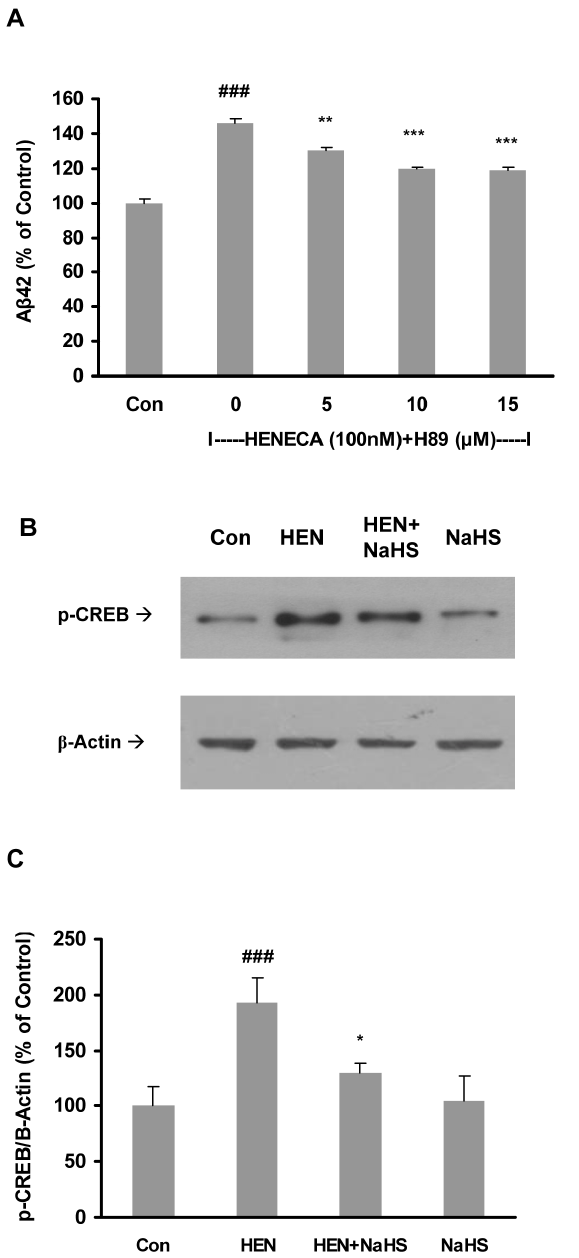
Figure 5. Effect of NaHS on expression of A2A receptors. A–B : Representative gels (A) and histogram (B) demonstrating the effect of pretreatment with NaHS (100 m M, 12 hours) did not attenuate the effects of HENECA (100 nM, 24 hours) on protein expression of A2A receptor. C : Effect of NaHS (100 m M) on production of A b 42 in cells pre- treated with A2A receptor antagonist, ZM 241385 (50 nM). Control values were adjusted to 100%. Data are given as means 6 S.E.M, n=4– 6. ## p , 0.01; ### p , 0.001 vs Con group. Con, control; HEN,